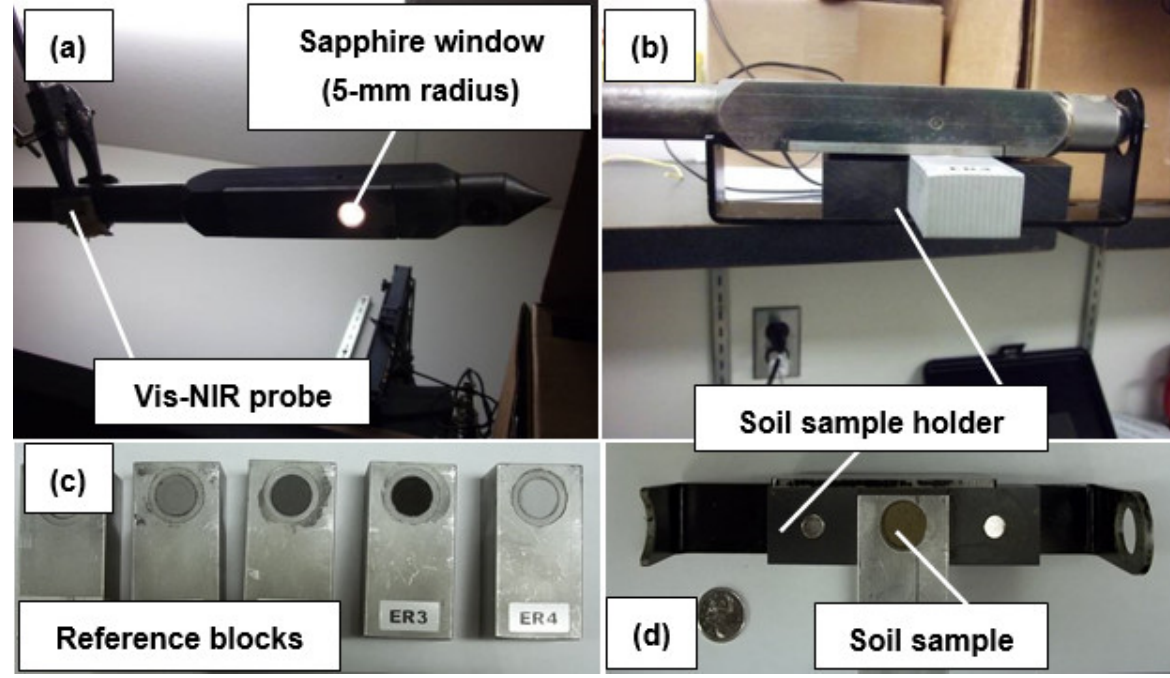
Figure 3. Illustration of the vis–NIR soil profiling tool during laboratory measurements (sapphire window on vis–NIR probe ( a ), soil sample holder ( b ), reference blocks ( c ) and soil sample ( d )).